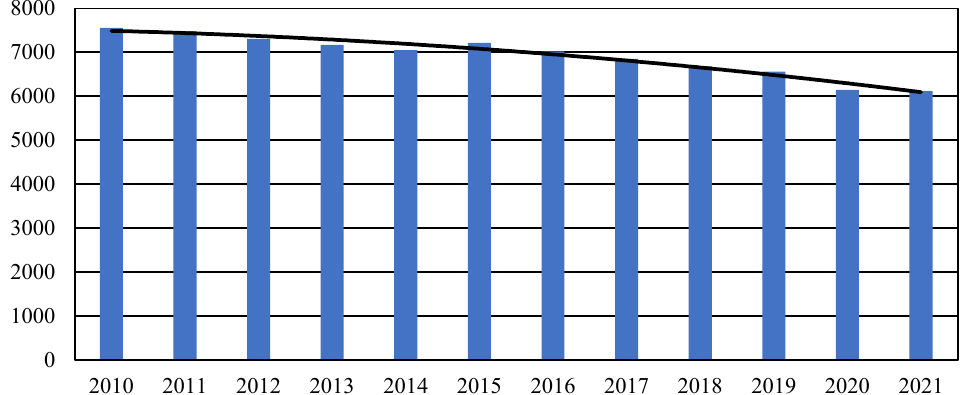
Figure 8. The potential of livestock by-products for production of gas-like types of fuel in Lithuania (thous. m 3 ).